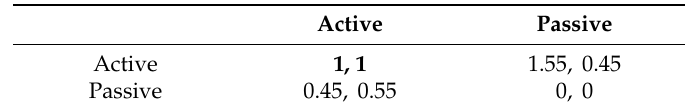
Table 12. Payo ff matrix A for 2 × 2 (Scrum Master vs. OTM) game for the most e ff ective team with